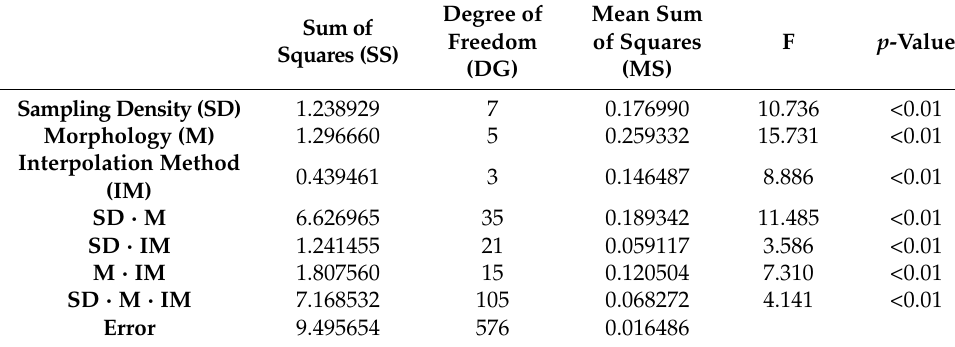
Table 3. Results of ANOVA test for the median